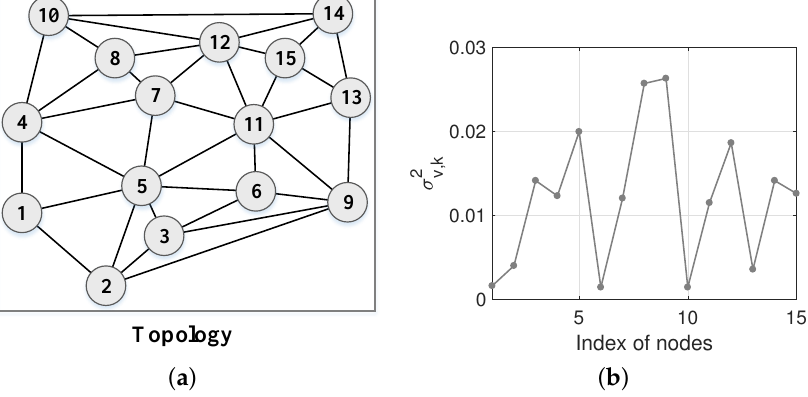
Figure 1. Network topology and noise profile: ( a ) network topology; ( b ) noise profile.